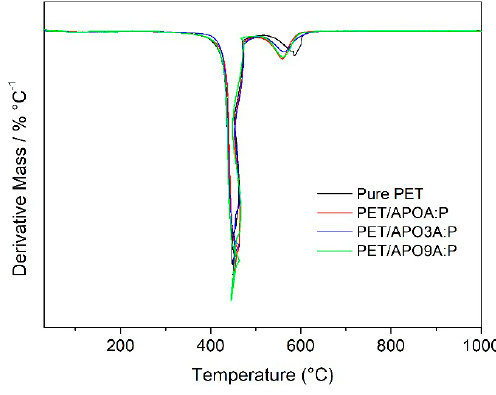
Figure 6. Derivative mass curves of pure PET and PET nanocomposites.